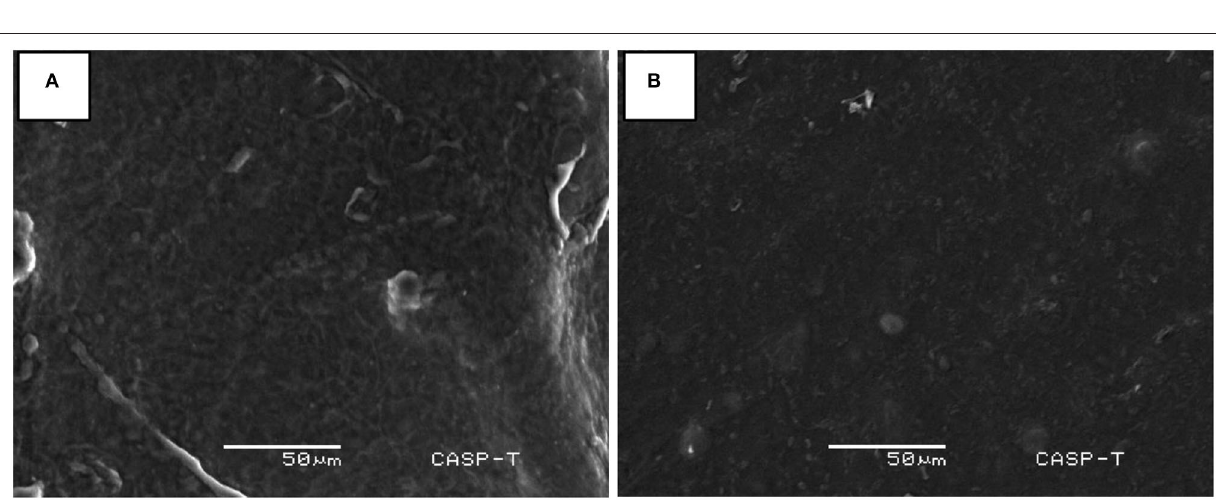
water with immobilized AA-18 detoxified 35% of Hg 2 + after 12 days whereas 90% of Hg 2 + was remediated from industrial effluent by immobilized AA-18 ( p < 0.05) as shown in Figure 2D .